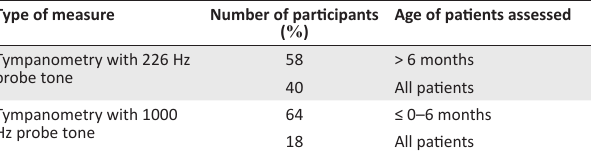
TABLE 2: Age of patients assessed by various acoustic immittance measures.